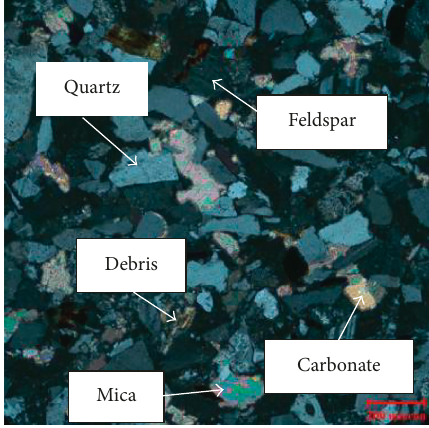
Figure 1: Microscope image of the sandstone